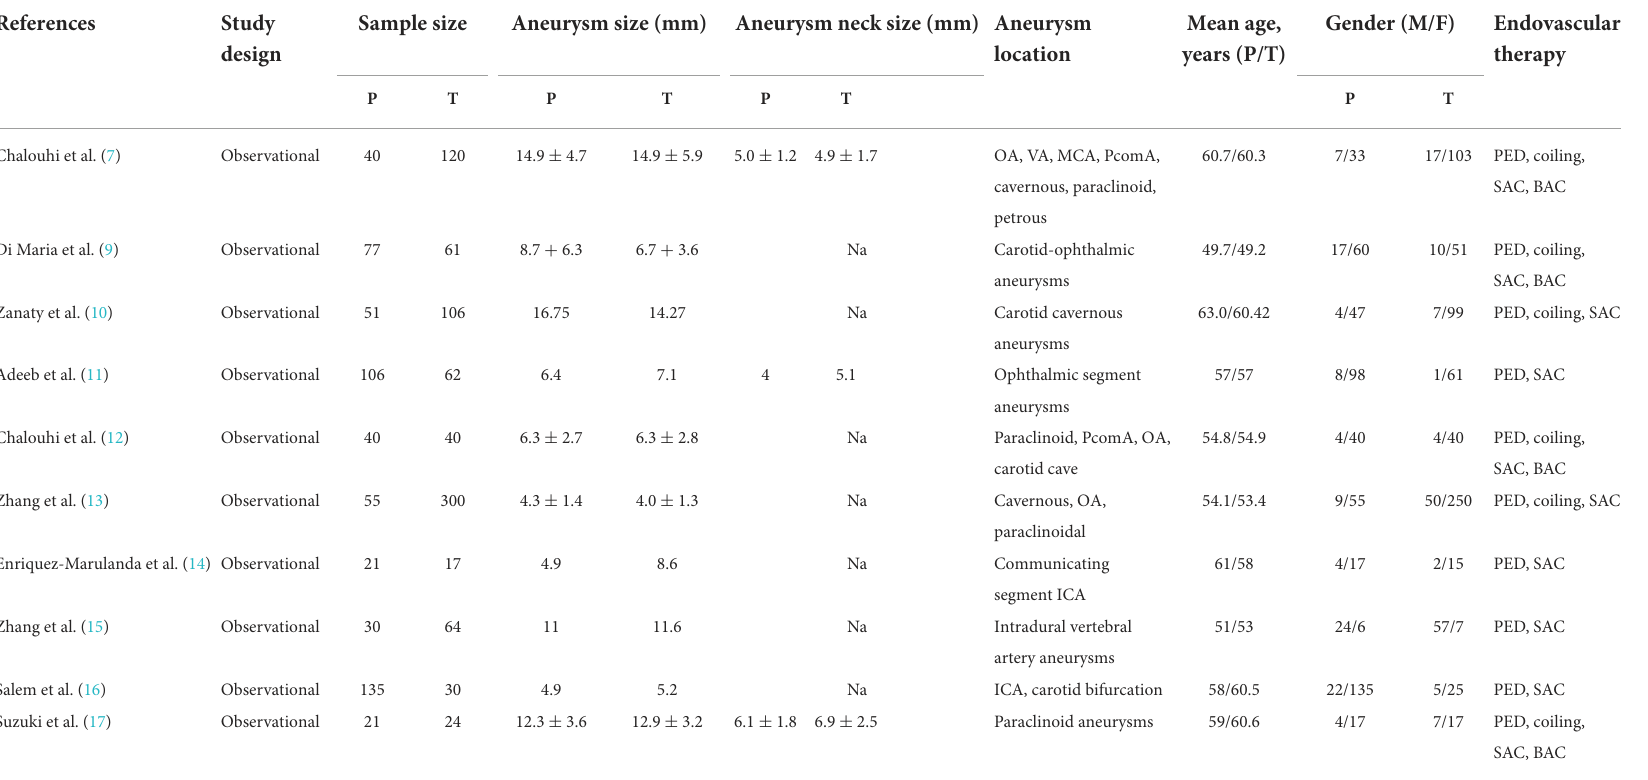
TABLE 1 Baseline characteristics of the included